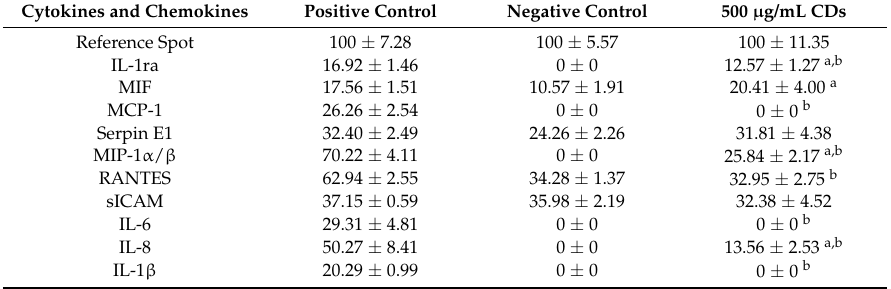
Table 2. Quantification of cytokines and chemokines secreted by Whole Blood Cells (WBCs) not stimulated with LPS after treatment with medium only (negative control), medium containing LPS (positive control) or medium containing 500 μ g/mL CDs. Membranes were subjected to chromogenic exposure. Data is represented as mean ± SD. Significance indicated by a CDs at 500 μ g/mL significantly different ( p < 0.01 compared to negative control, b CDs at 500 μ g/mL significantly different ( p < 0.001) compared to the positive control.